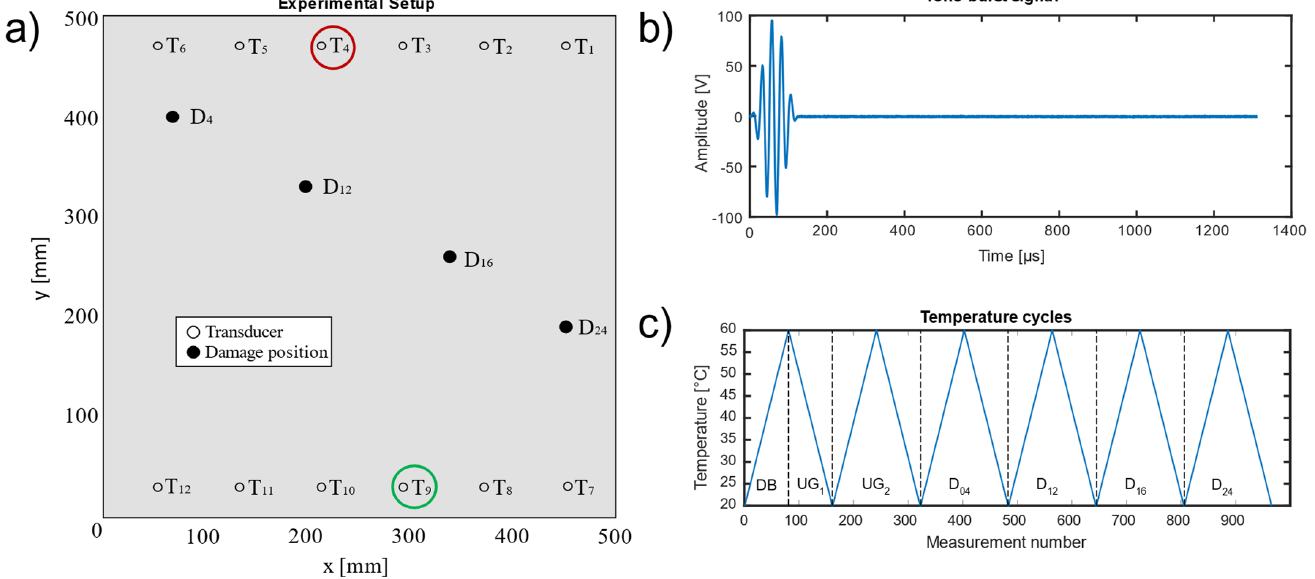
Figure 1. ( a ) Schematic of the experimental setup [12]. The analysed sensor combination is indicated by circles (the red circle indicates the transmitter T4, whereas the green circle indicates the receiver T9). The considered damage positions (D 04 , D 12 , D 16 , D 24 ) are indicated by filled black dots. ( b ) 40 kHz Hann-windowed tone-burst signal with five cycles. ( c ) Temperature of the climatic chamber for each measurement number, where the dotted lines indicate the corresponding groups of the database, undamaged and damaged measurements.